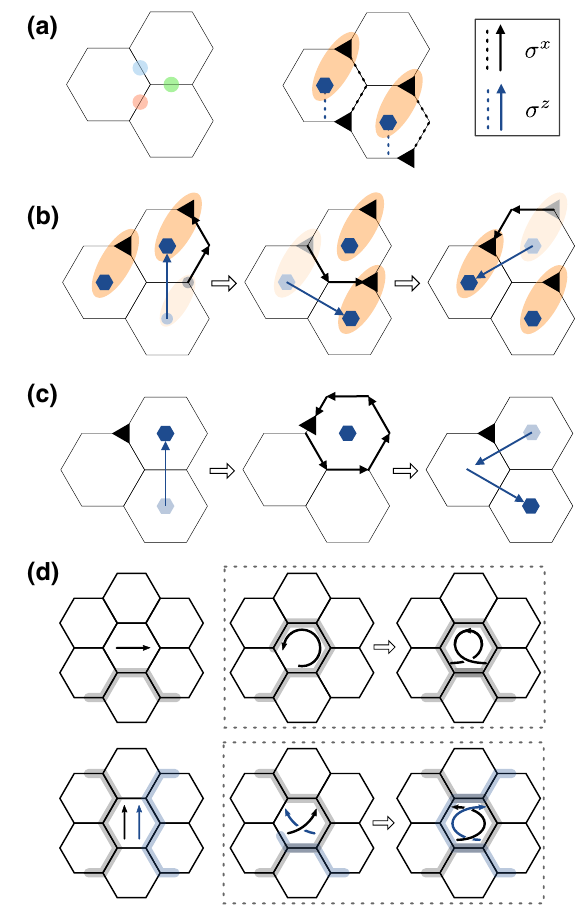
FIG. 10. Small-scale experimental realization. (a) In a three- plaquette toric code, the TEE can be measured using the three connected domains as in Fig. 4, consisting of three qubits. On the right, we show the initial configuration of the anyons prepared by ˆ σ x and ˆ σ z : the anyons can also be moved using the same opera- tors. (b) Braiding steps to realize the exchange of e × m particles. The solid lines are string operators used to drag the particles. (d) We can extract other S -matrix elements by following (c) twice with some specific anyons removed. Here, we only keep the m on the left and the e on the right. Applying (c) twice results in three parallelized steps as shown, which gives S em = S me = − 1. (d) The braiding for general Abelian and non-Abelian anyons can be simulated on a small system as shown. The left and right diagrams depict the interfered paths of the anyons. Note that the final anyon configurations are